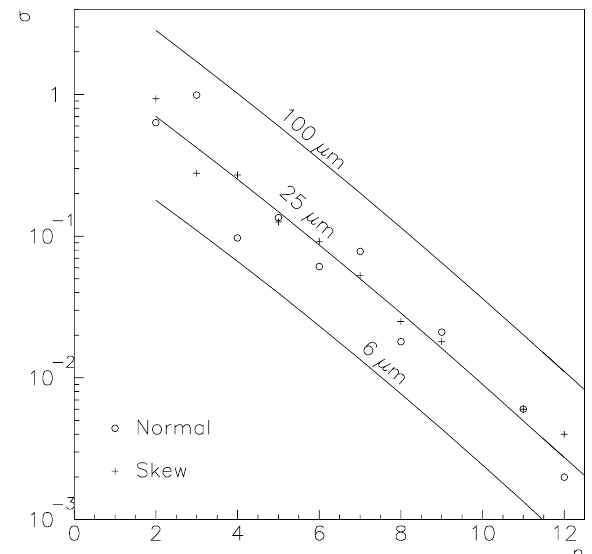
FIG. 4. rms of the multipoles along the axis for the LHC dipole prototype MBP2O1 (markers) and scaling law for different am- plitudes of random displacements d (solid line).